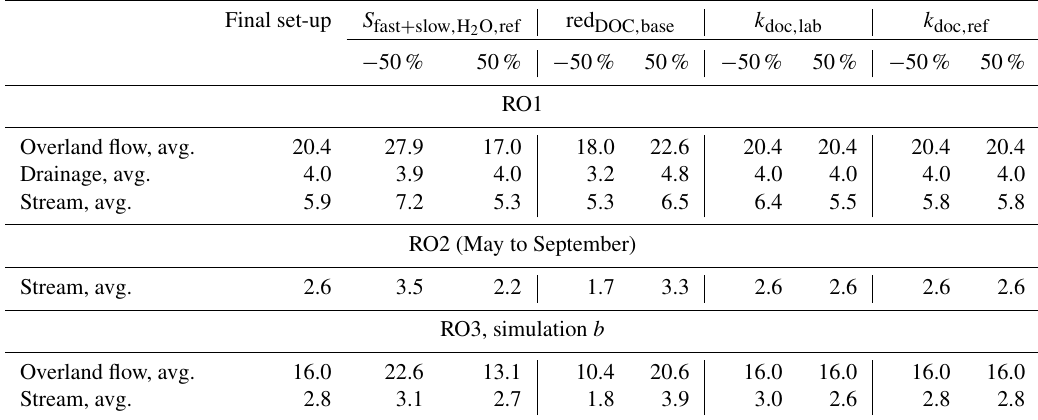
Figure 11. Averages of simulated net primary production ( NPP ), dry deposition of soluble organic C onto the canopy and leaching of DOC from leaves ( F add2can , DOC ), wet deposition of DOC (DOC in rain, F WD , DOC ) and throughfall DOC flux ( F TF , DOC ), as well as total DOC and CO 2 exports into the inland water network ( F RO + F DR + F soil2flood + F soil2river ) over the simulation period 1980–2000. Table 7. Sensitivity of simulated average DOC concentrations (mgCL − 1 ) in surface runoff, drainage and headwater streams to changes in key parameters in